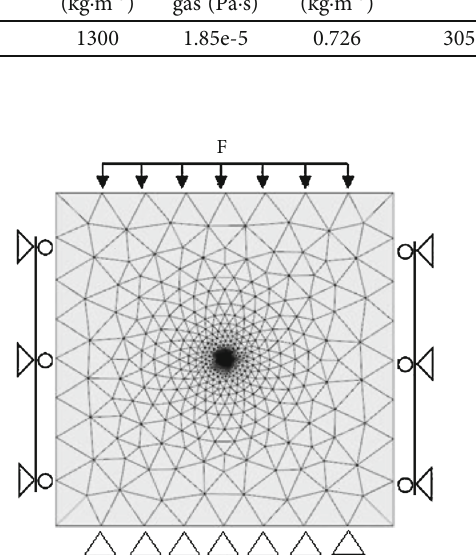
Figure 4: Three-dimensional numerical